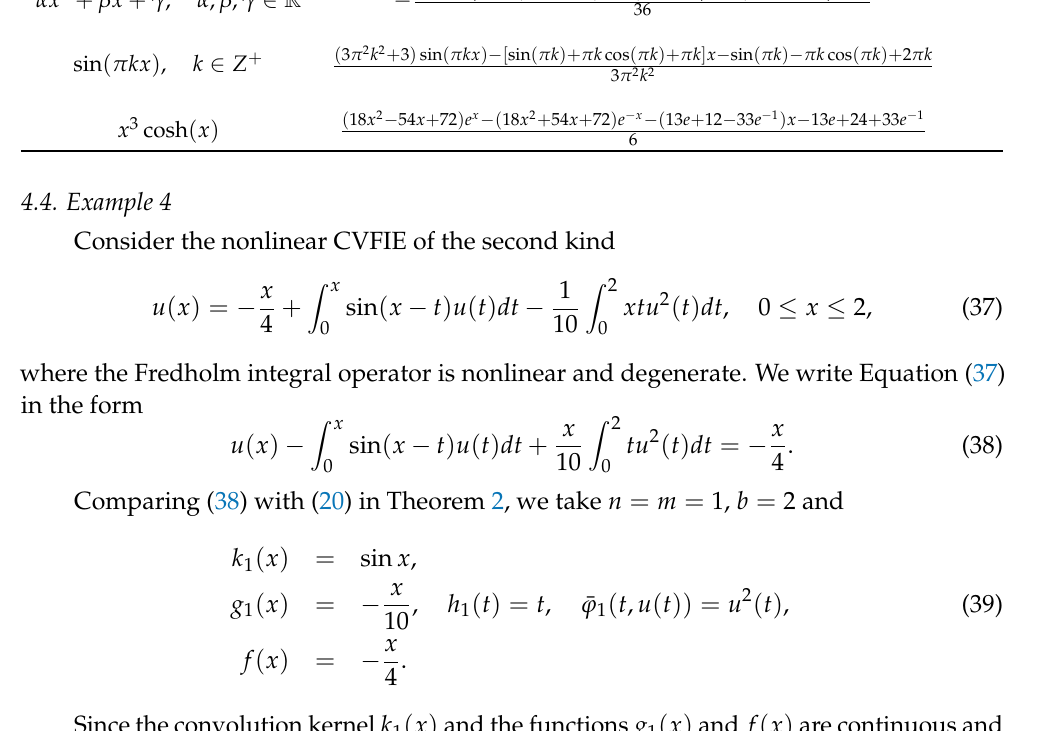
Table 1. Exact solution of the linear CVFIE (33) for three different cases of the input function f ( x ) . f ( x ) u ( x ) α x 2 + β x + γ